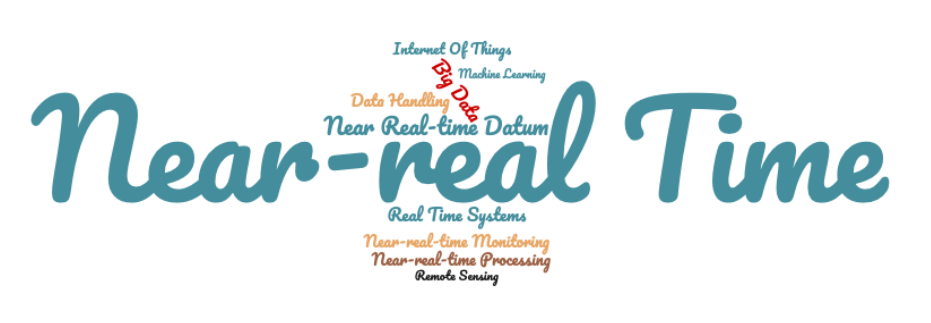
Figure 7. Tag cloud from the keywords used in the survey of the